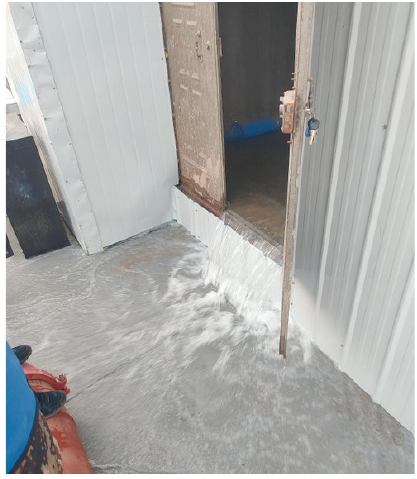
Figure 17. Ruptured pipe on site.